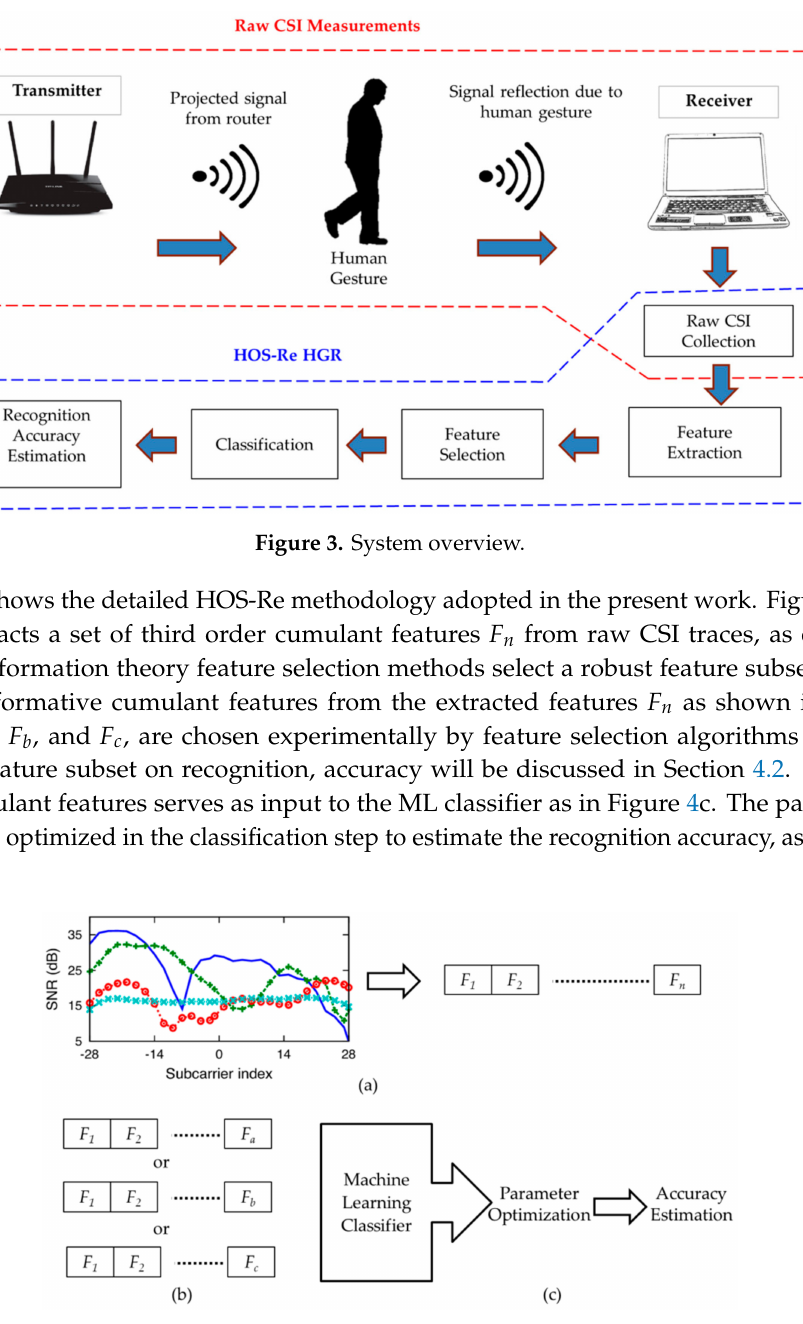
Figure 4. HOS-Re methodology representing ( a ) Feature extraction; ( b ) Feature selection; ( c )